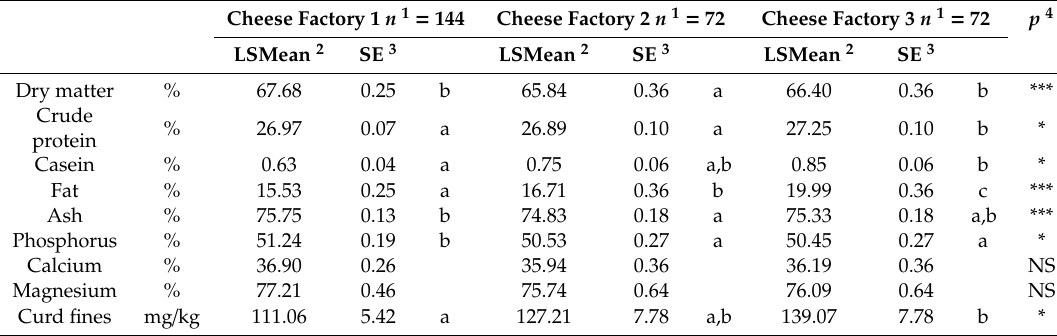
Table 4. Di ff erences among cheese factories in estimated cheese-making loss values and curd